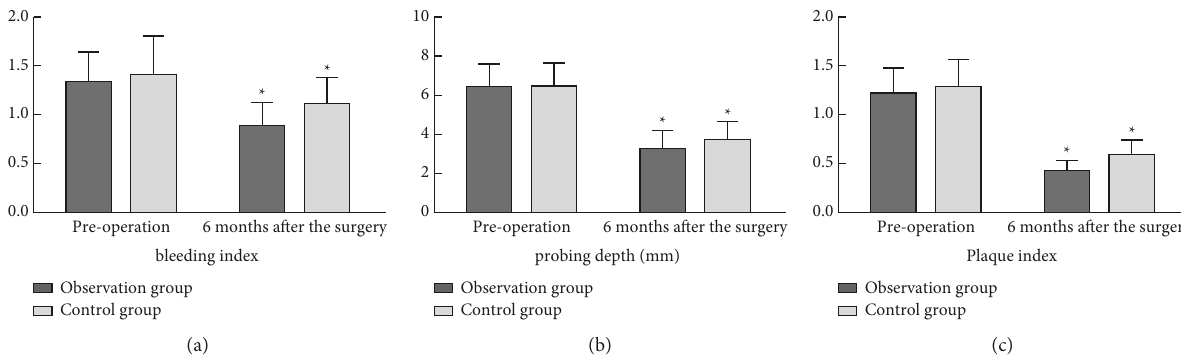
Figure 3: Comparison of soft tissue between the groups treated with maxillary sinus external/internal lift. Note: Compared with pre- operative, Table 1: Comparison of postoperative complications between the groups treated with maxillary sinus external/internal lift ( n Groups group